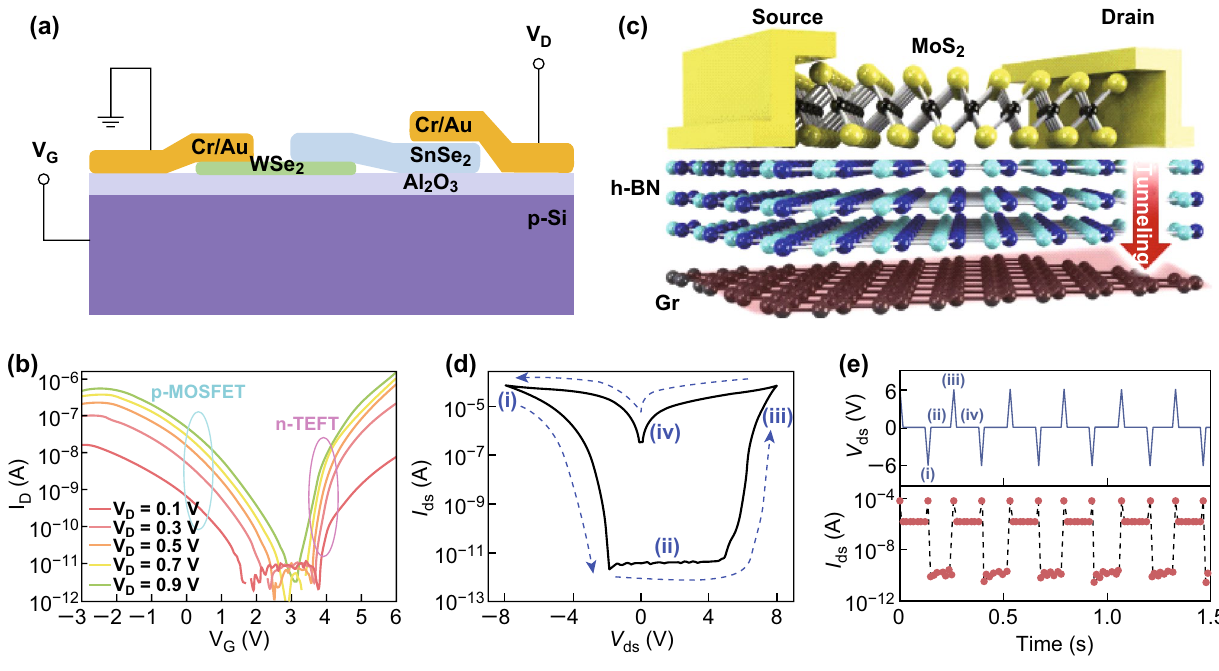
Fig. 8 Electronic devices based on 2D heterostructure. Transistor based on the BTBT in WSe 2 /SnSe 2 heterostructure ( a ) and its channel current ( b ) as a function of V G at certain V D from 0.1 to 0.9 V. Reprinted with permission from Ref. [52]. Schematic diagram of programmable floating‑ gate memory based on MoS 2 /hBN/graphene heterostructure ( c ), the hysteresis loop of I ds when V ds sweeps forward and backward ( d ) and the corresponding I ds when periodically repeat the four states by setting V ds to − 6, 0, and + 6 V ( e ). Reprinted with permission from Ref.